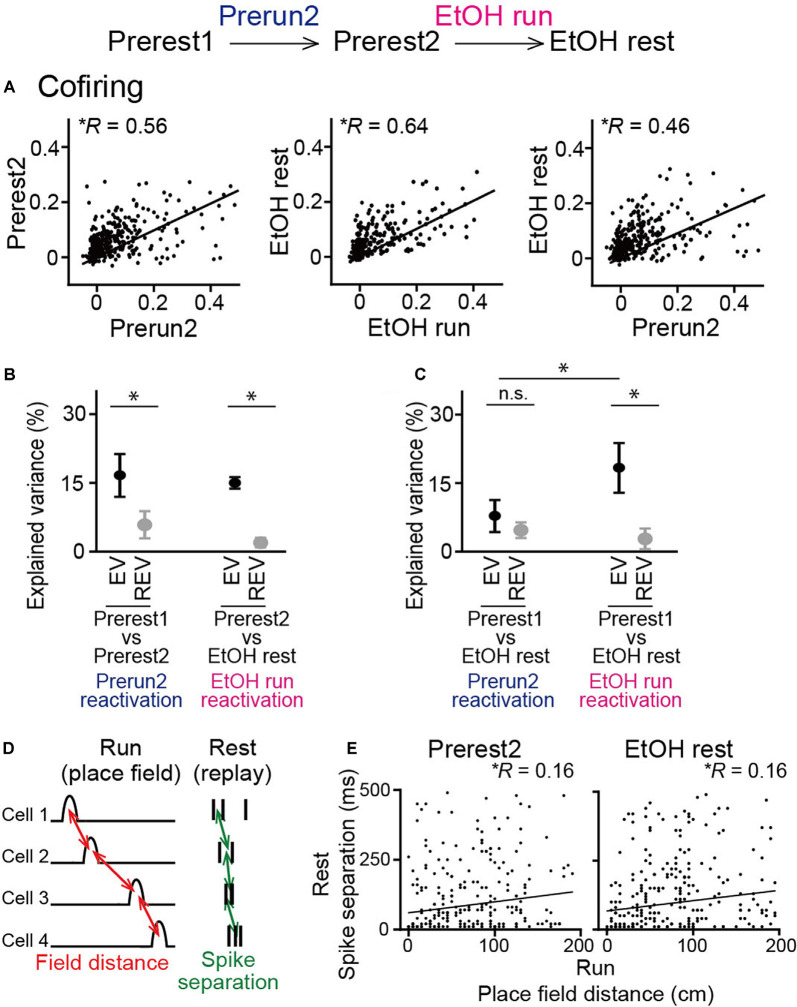
No pronounced changes in cofiring of place cell pairs during rest periods in ethanol-treated rats. (A) Cofiring of place cell pairs between a run session and the subsequent rest session (left, Prerun2 vs. Prerest2; middle, EtOH run vs. EtOH rest; right, Prerun2 vs. EtOH rest). Each dot represents each cell pair. All graphs showed significant positive correlations (P < 0.001). Only place cells identified in each run session were included for this analysis (n = 384, 475, and 384 neuron pairs from six rats). (B) Explained variance (EV) across groups of sessions (n = 6 rats). Two rest sessions and one run session used for the analysis were described below. In both groups of sessions, EV was significantly higher than the reversed EV (REV). *P < 0.05, paired t-test. (C) Same as B but for the Prerest1 session vs. the EtOH session. *P < 0.05, paired t-test followed by Bonferroni correction. (D) Schematic illustration of sequential reactivation analysis. For each place cell pair, a place field distance between the two cells during the previous run session (red, field distance) and an absolute average difference in spike timing between the two cells during a rest session (green, spike separation) were computed. (E) Relationship between place field distance and spike separation for all place cell pairs (Prerest2: n = 339 neuron pairs; EtOH rest: n = 334 neuron pairs). Each dot represents each cell pair. Both graphs showed significant positive correlations (P < 0.01). n.s.: not significant.